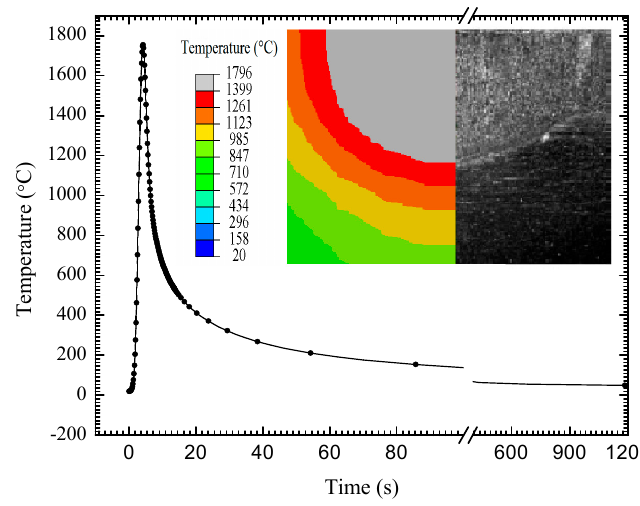
Figure 8. Temperature variation curve and weld pool morphology.